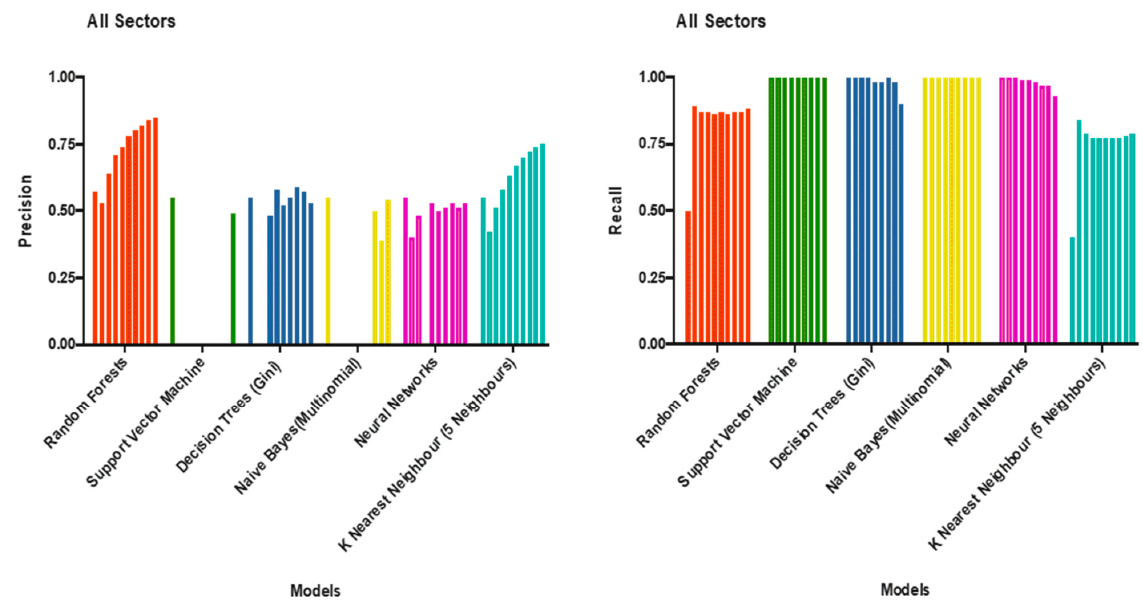
Figure 3. Precision for Buy signals and Recall for Sell signals of various classifiers over the S&P500 dataset. Bars are ordered from Day-1 to Day-10 from left to right.